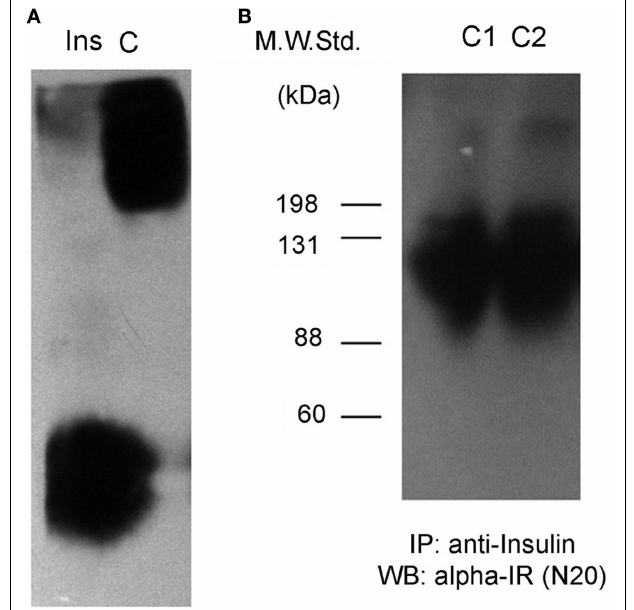
FIGURE 1 | Insulin interacts with a soluble receptor in plasma from control rats . (A) Western blots against insulin after native gel electrophoresis from an insulin standard (Ins) and a plasma sample from an adult maleWistar rat (C). Insulin staining for the plasma sample is not located at the same position as the insulin standard, displaying less migration in the gel for plasma insulin. (B) Insulin-receptor (alpha-IR) staining byWestern blot after denaturing gel electrophoresis of previously insulin-immunoprecipitated plasma samples from two control rats (C1 and